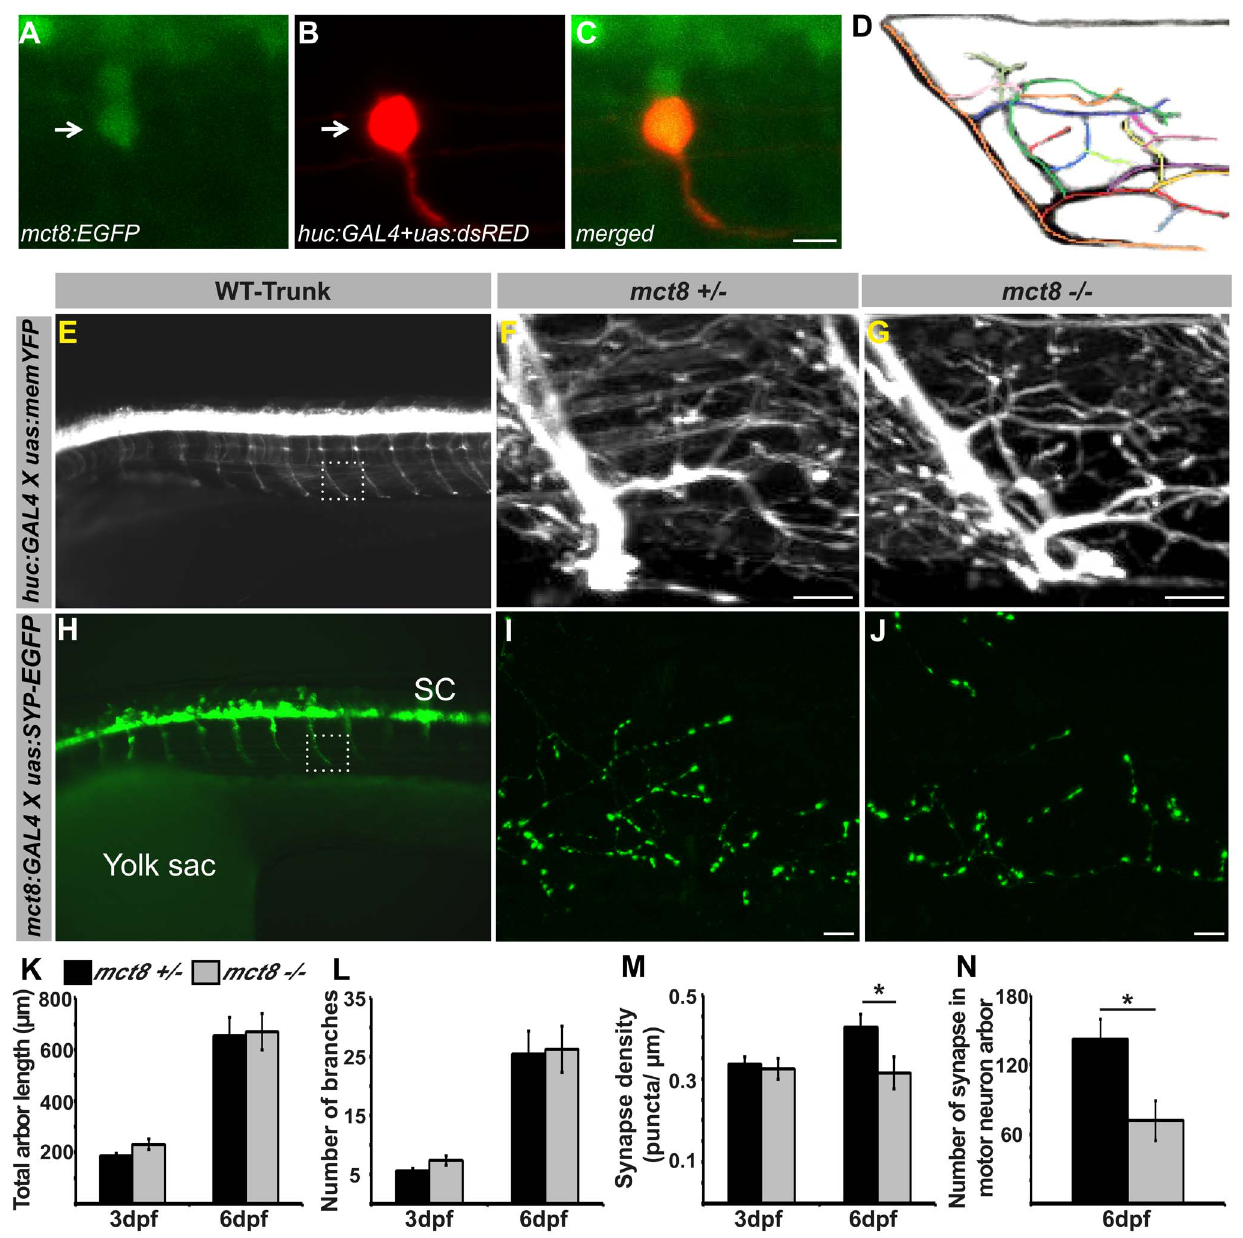
Figure 6. Loss of MCT8 reduces synaptic density in axonal arbors of the motor neuron. A–C . Confocal imaging of a 2 dpf live tg ( mct8:EGFP ) embryo co-injected with huc:GAL4 and uas:tRFP constructs revealed co-localization of mct8 (green) and the huc pan-neural marker (red) in a motor neuron. D . Schematic illustration of an axonal arbor in a motor neuron. Each color represents a single branch that was subjected to ImageJ software analysis. E . Lateral view of a 3 dpf tg(huc:GAL4Xuas:memYFP) embryo. memYFP expression driven by the huc promoter is observed in the spinal cord (SC) and in descending motor neurons. The dashed frame marks a single motor neuron that was selected for further comparative studies. High magnification of the framed area is shown in the trunk of 6 dpf tg(huc:GAL4Xuas:memYFP)/mct8 + / 2 and tg(huc:GAL4Xuas:memYFP)/mct8 2 / 2 representative larvae ( F and G , respectively). H . Lateral view of a 30 hpf tg(mct8:GAL4Xuas:SYP-EGFP) embryo. SYP-EGFP expression driven by the mct8 promoter is observed in the spinal cord (SC) and in descending motor neurons. In order to compare the number of synapses in mct8 + / 2 and mct8 2 / 2 larvae, single motor-neuron arbors were selected (dashed frame). High magnification of the dashed frame is shown in 6 dpf tg(mct8:GAL4)/ (uas:SYP-EGFP)/mct8 + / 2 and tg(mct8:GAL4)/(uas:SYP-EGFP)/mct8 2 / 2 representative larvae ( I and J , respectively). The total arbor length ( K ) and the number of branches ( L ) were measured in 3 and 6 dpf mct8 + / 2 larvae and in 3 and 6 dpf mct8 2 / 2 larvae. M . Synapse density in the axons of the motor-neurons was measured along the last 50 m m of a single branch in 3 and 6 dpf mct8 + / 2 larvae and in 3 and 6 dpf mct8 2 / 2 larvae. N . The total number of synapses was measured in the motor-neuron arbor of 6 dpf mct8 + / 2 and mct8 2 / 2 larvae. Scale bar=30 m m. Values represented as means 6 SEM (standard error of the mean). Statistical significance determined by t -test: Two-sample assuming unequal variances followed by one- sample Kolmogorov-Smirnov test, to assume normal distribution (* p , 0.05 ).